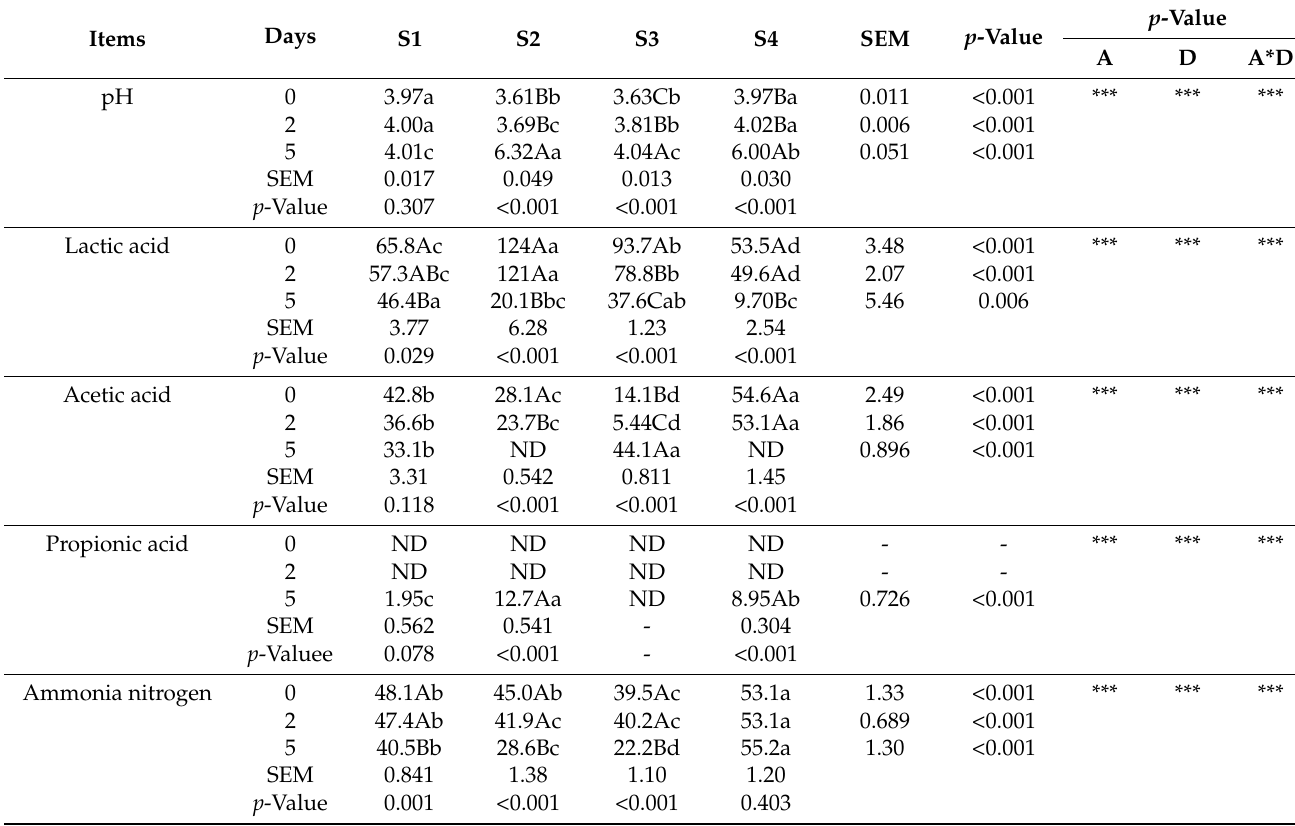
Table 5. pH, organic acid contents (g/kg dry matter) and ammonia nitrogen contents (g/kg total nitrogen) of whole-plant corn silages during aerobic exposure (n = 3).